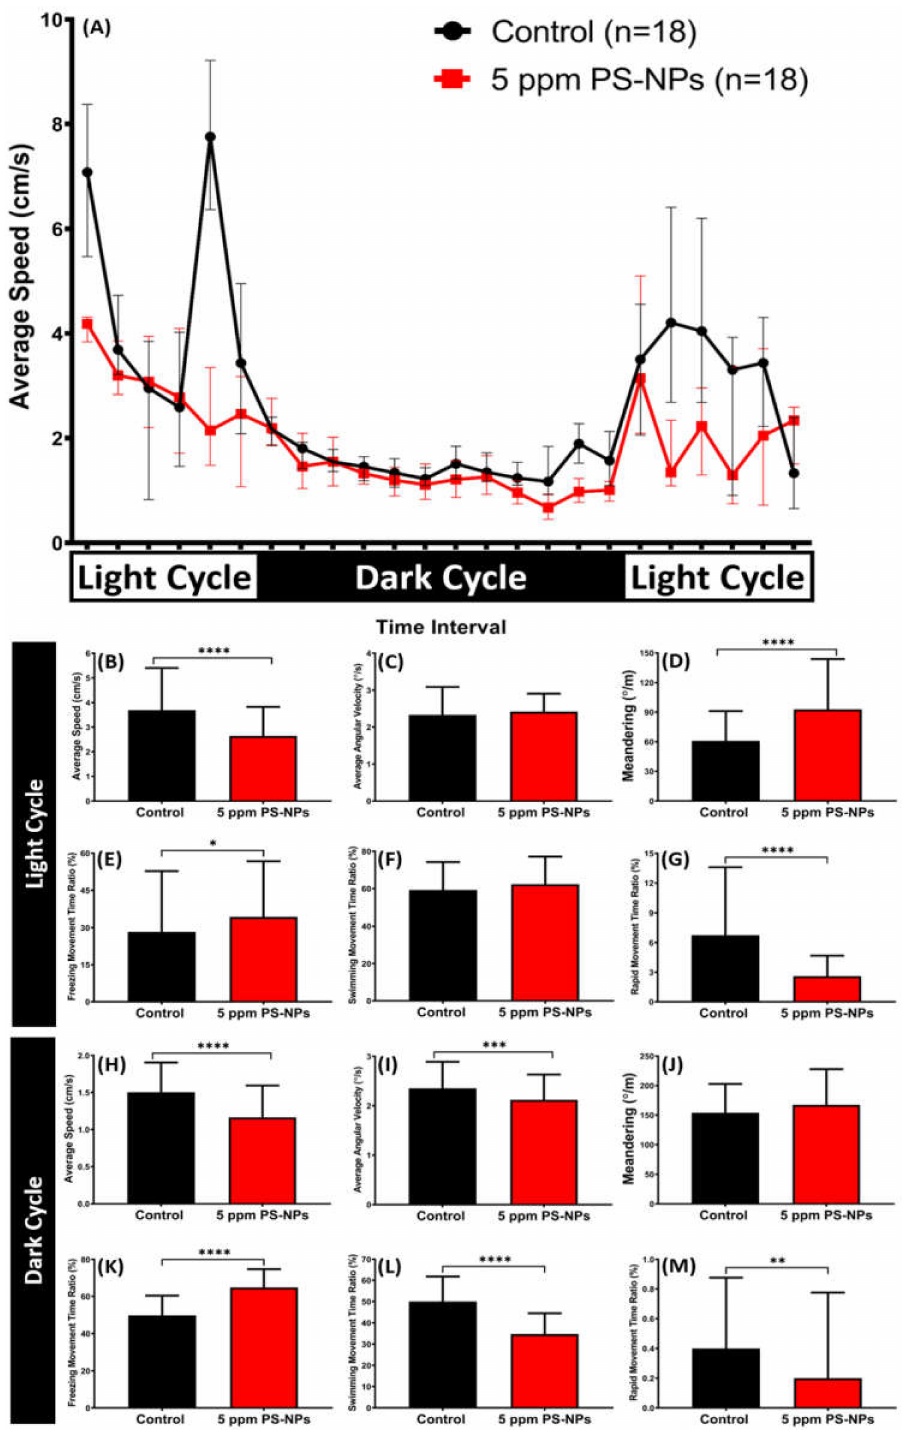
Figure 7. The circadian rhythm locomotion activity assay for control and 5 ppm polystyrene nanoplastics (PS-NPs)-exposed zebrafish groups after a seven-week exposure. ( A ) Comparison of the time chronology changes of the average speed between the control and the PS-NPs-exposed fish in light and dark cycles. The white area shows the light period and the black area shows the dark period. Comparison of the average speed ( B , H ), average angular velocity ( C , I ), and meandering ( D , J ), freezing movement time ratio ( E , K ), swimming movement time ratio ( F , L ), and rapid movement ratio ( G , M ) during the light and dark cycles, respectively. The data are expressed as the median with interquartile range and were analyzed by Mann–Whitney test ( n = 18 for control; n = 18 for PS-NPs-exposed fish; * p < 0.05, ** p < 0.01, *** p < 0.001, ****, p <